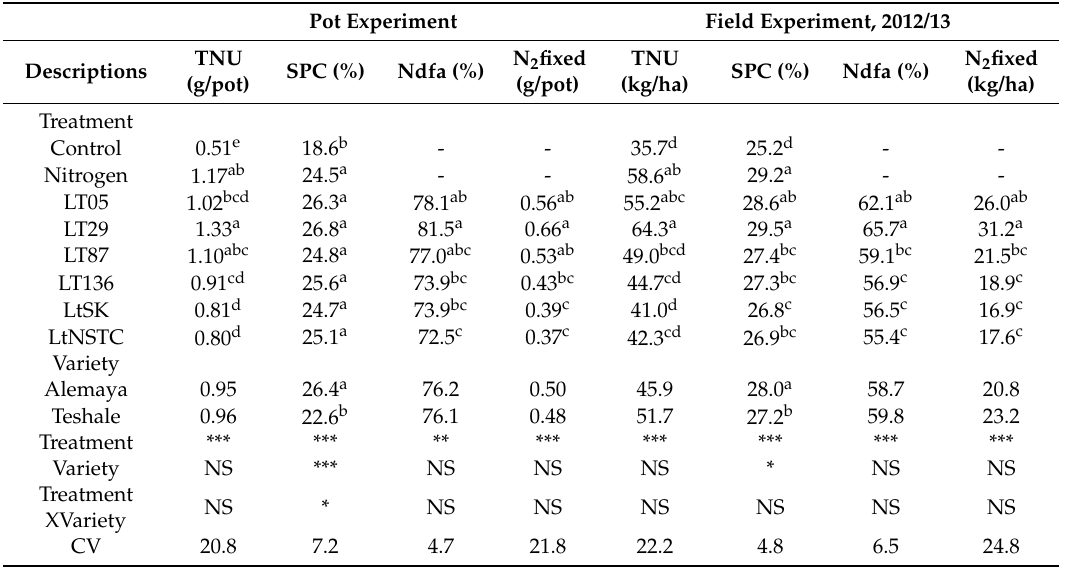
Table 5. Effect of Rhizobium inoculation and N fertilizer application on total N uptake (TNU), seed protein concentration (SPC), percentage N derived from the atmosphere (%Ndfa) for the seed, and amount of seed N fixed for lentil